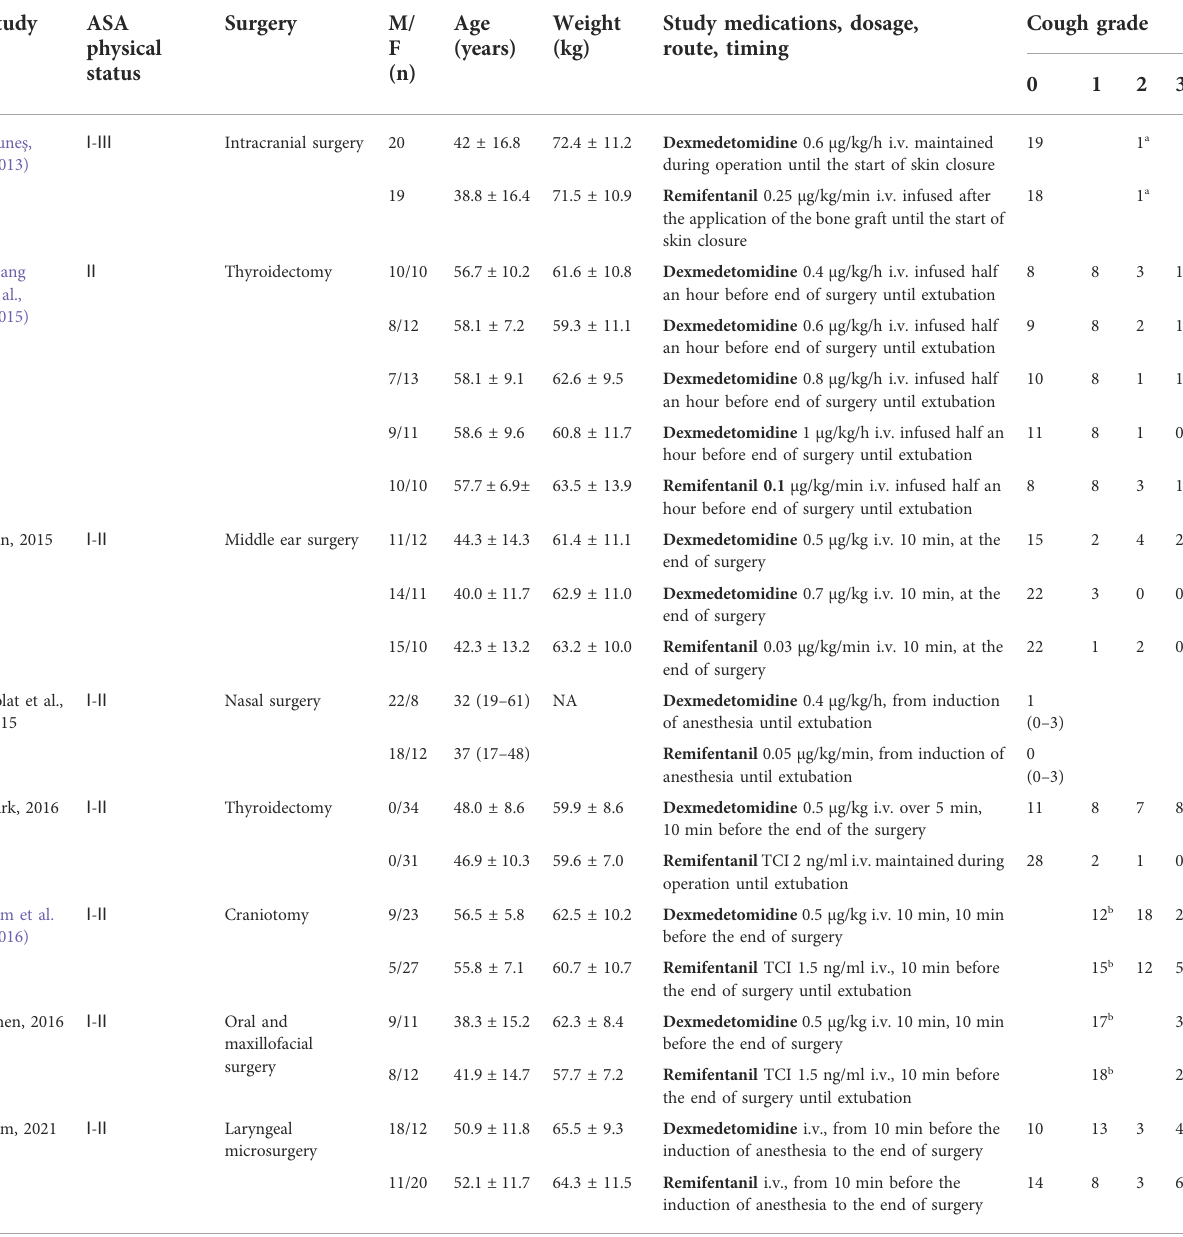
TABLE 1 Characteristics of included